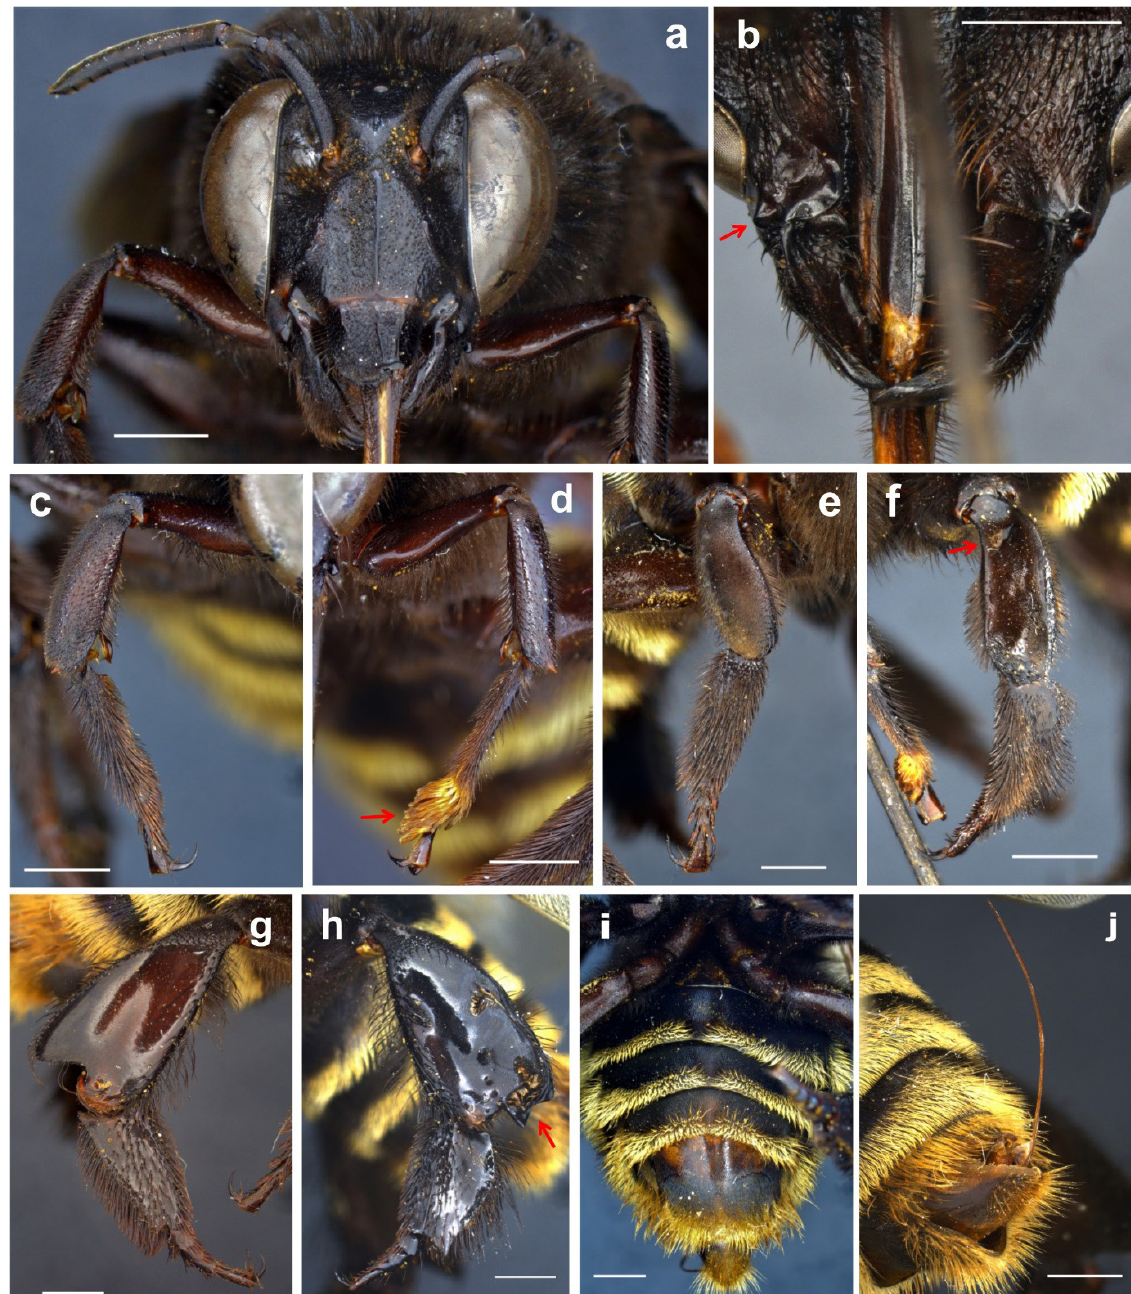
Fig 1. Eulaema meriana gynander: a. Front view of the head, b. Ventral part of the mandibular insertion (left side with a conspicuous bifurcated lobe), c. Right foreleg, d. Left foreleg, e. Right middle leg, f. Left middle leg, g. Right hind leg, h. Left hind leg (with malformation), i. Ventral view of the abdomen (bilaterally asymmetric), j. Final tergites of the abdomen with a well-developed sting. Scale bars = 2